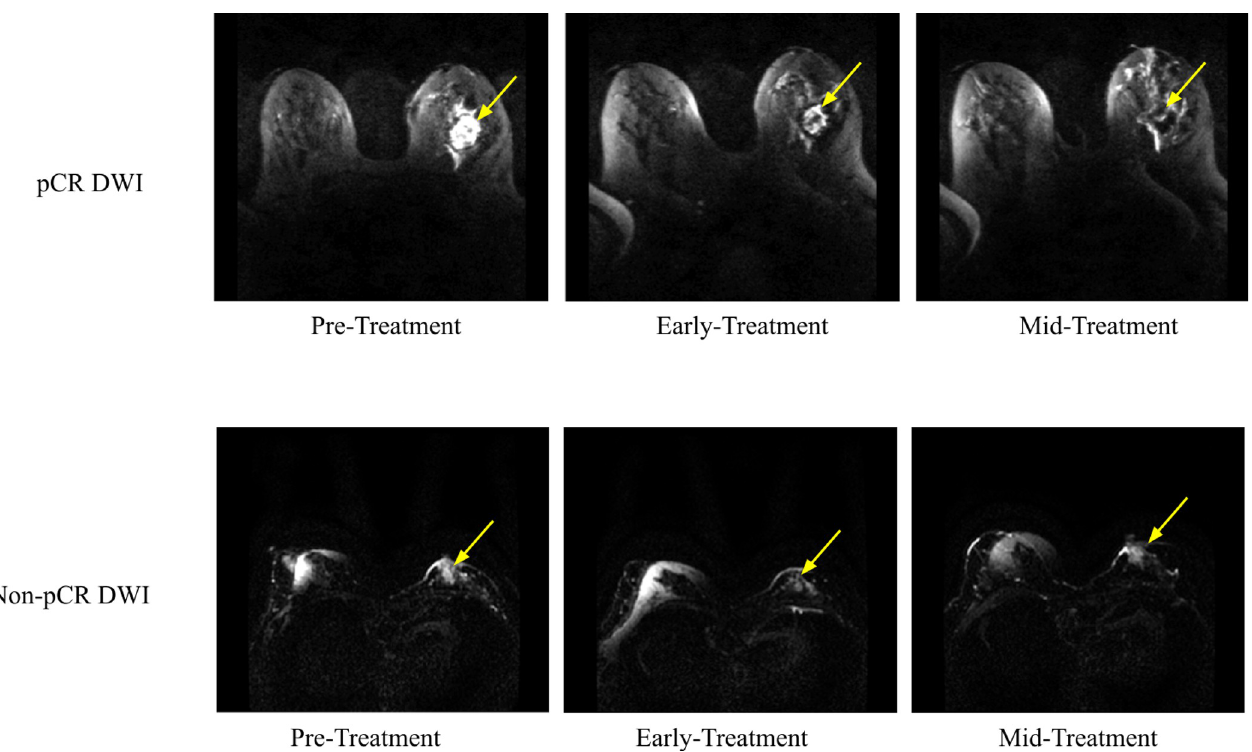
Fig 4. DWIs for (A) a pCR patient and (B) a non-PCR patient at the pre-treatment, early treatment, and mid-treatment time points. For (A), the 54 year old Caucasian patient had invasive ductal carcinoma with HR- and HER2-. For (B), the 51 year old Caucasian patient had invasive ductal carcinoma with HR+ and negative HER2-. The yellow arrow indicates the approximate location of the tumor. DWI acquisitions were done using a b-value of 800 s/mm 2 . DWI: diffusion- weighted imaging).